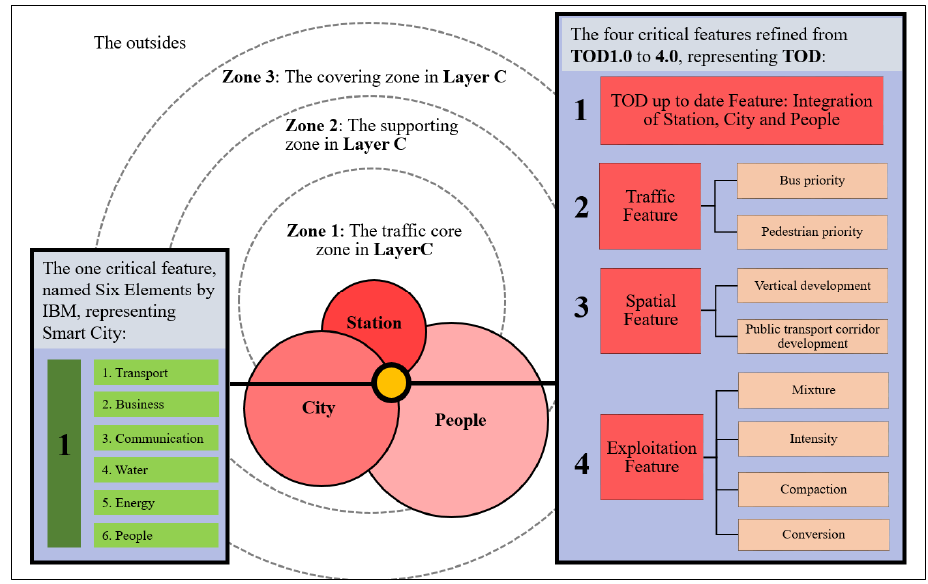
Figure 17. The features of the combination in Layer C.